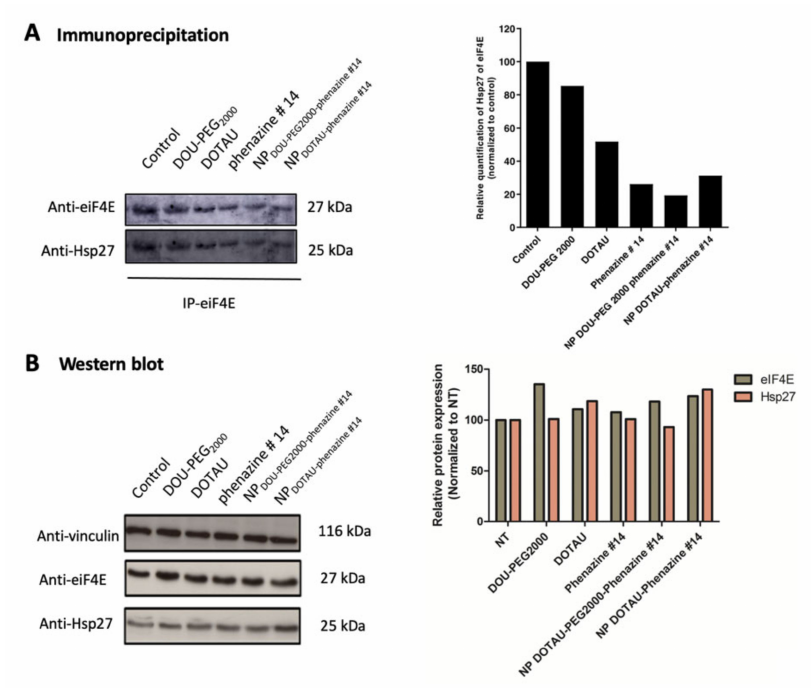
Figure 2. The encapsulated phenazine #14 with DOTAU and DOU-PEG 2000 at 100 µ M inhibits the interaction of eIF4E/Hsp27. ( A ) Co-immunoprecipitation of eIF4E showing the interaction of eIF4E and Hsp27, ( B ) Western Blot analysis showing the expression levels of eIF4E and Hsp27 compared to